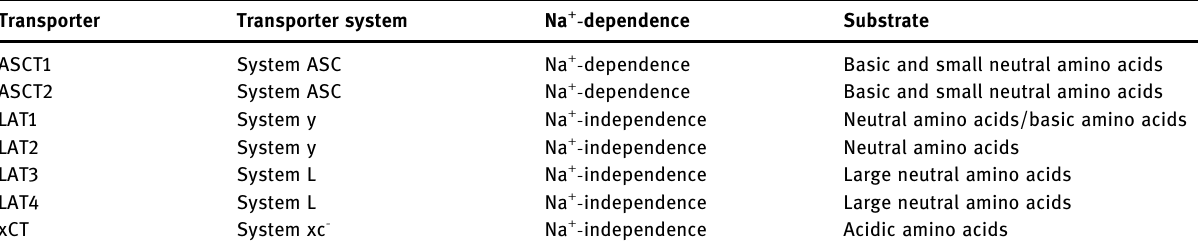
Table 1: Classi fi cation of ASCT, LAT, and cystine – glutamate exchange ( xCT ) transporters Transporter